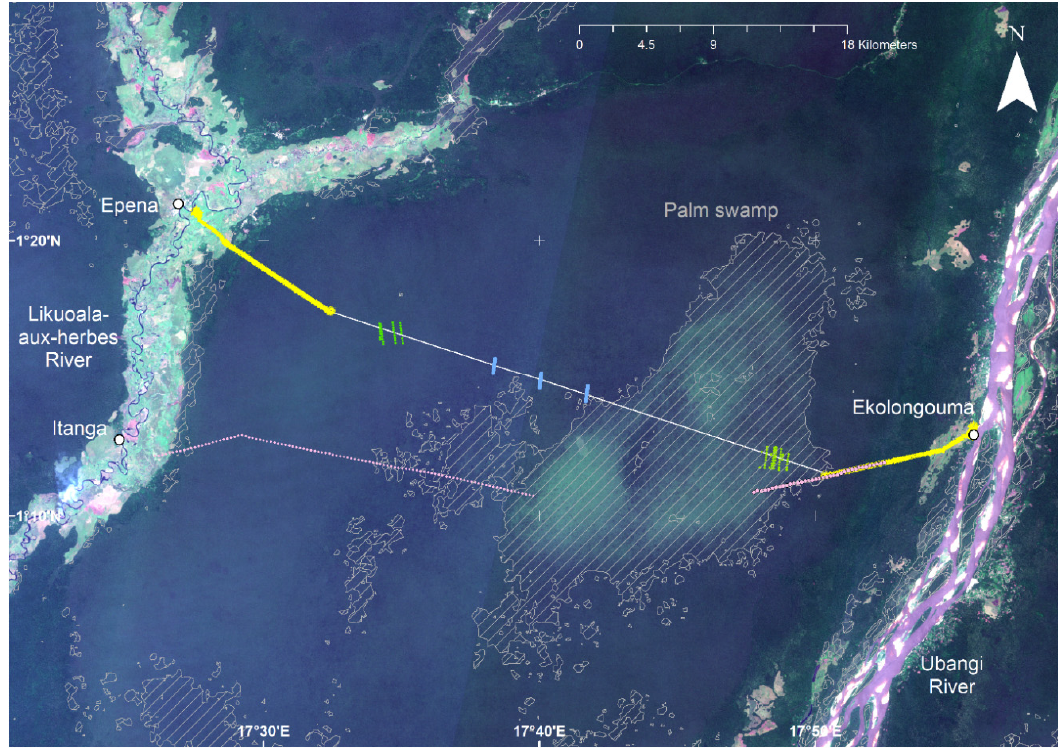
Figure 2. The locations of acquired data UAV LiDAR, ICESat, ICESat-2, field-measured peat depth and the area believed to be palm swamp (white hatched) [5]. A white line joins the LiDAR transects forming a path between the peat edges 43.8 km long, compared to 43.3 km direct-line distance. Background image is a Sentinel-2 composite, Copyright European Space Agency. Caption font colours correspond to figure data colours.